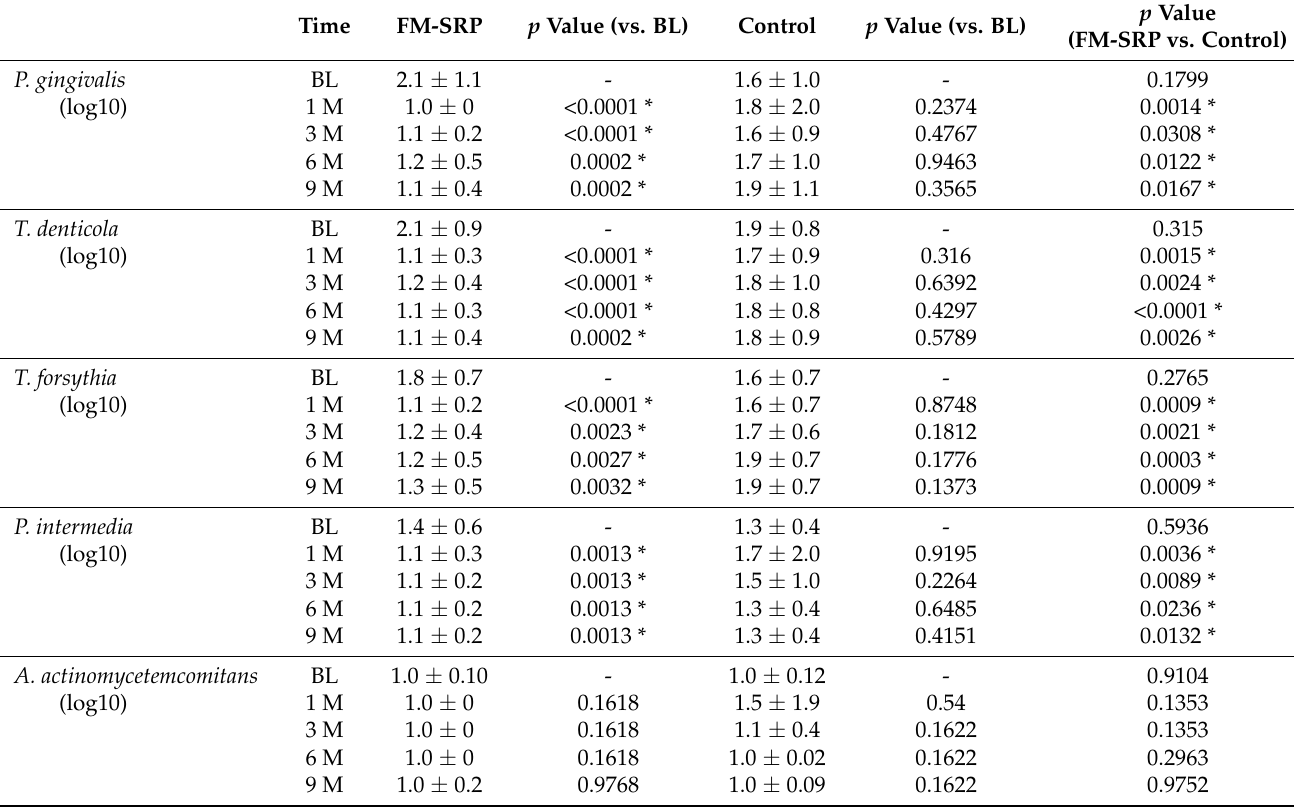
Table 3. Periodontal pathogen